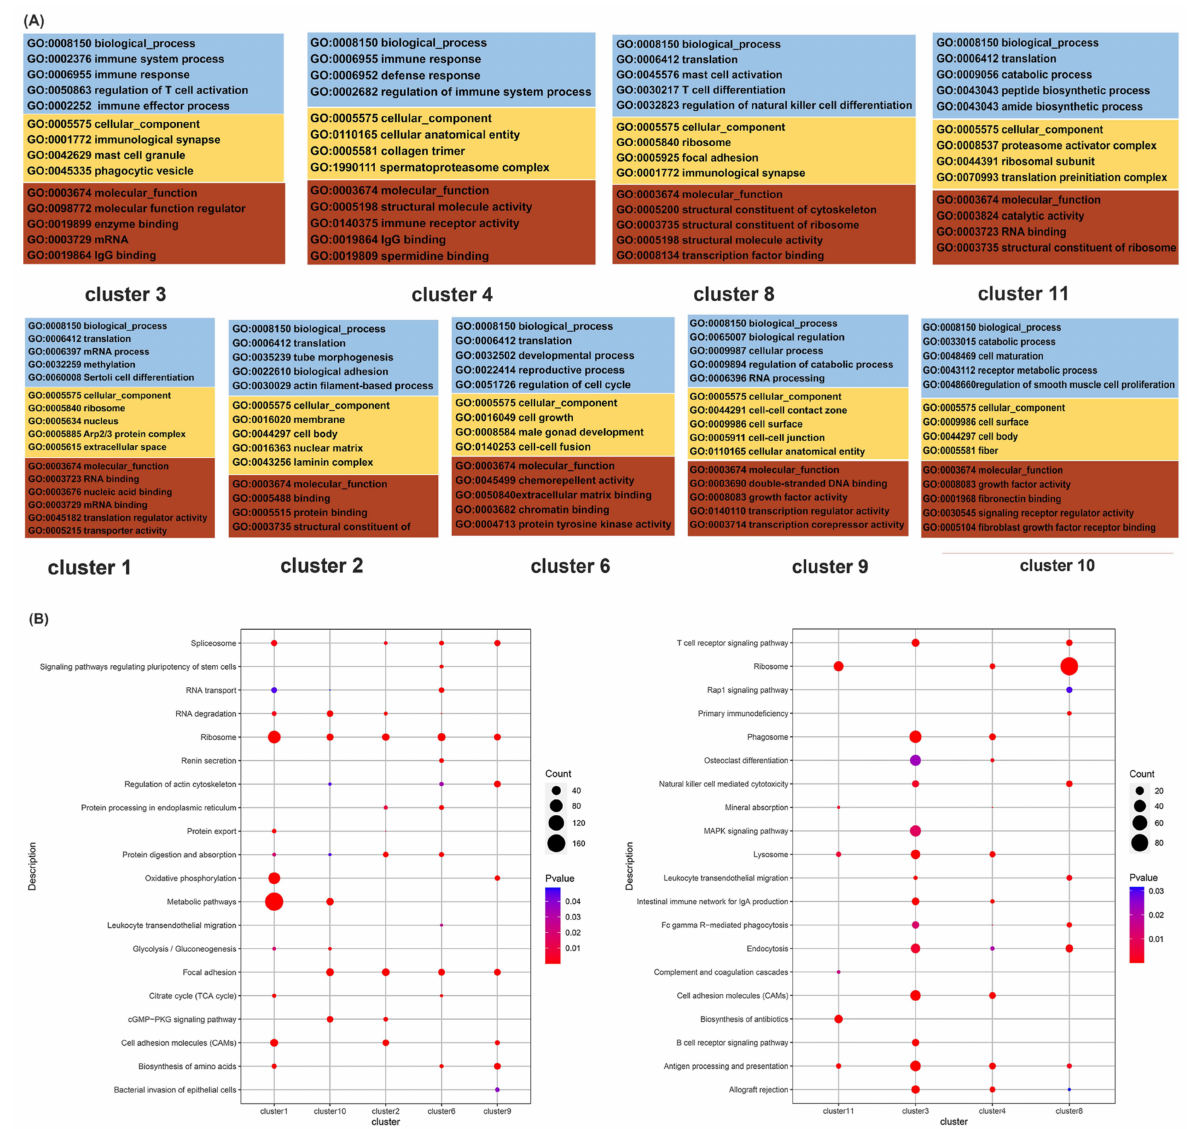
Figure 4. Functional enrichment analysis of testicular somatic cell types. ( A ) The top GO analysis of three somatic cell types. ( B ) The top KEGG analysis of three somatic cell